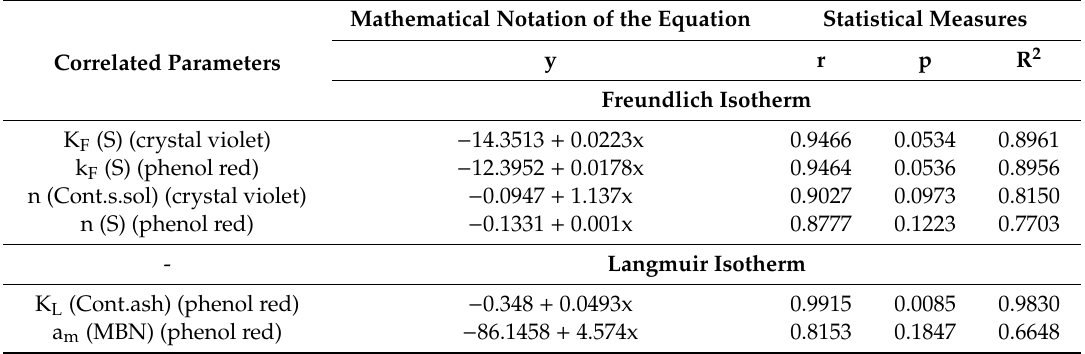
Table 4. Dependences between selected activated carbon parameters and the values of coe ffi cients in the Freundlich and Langmuir isotherm models.